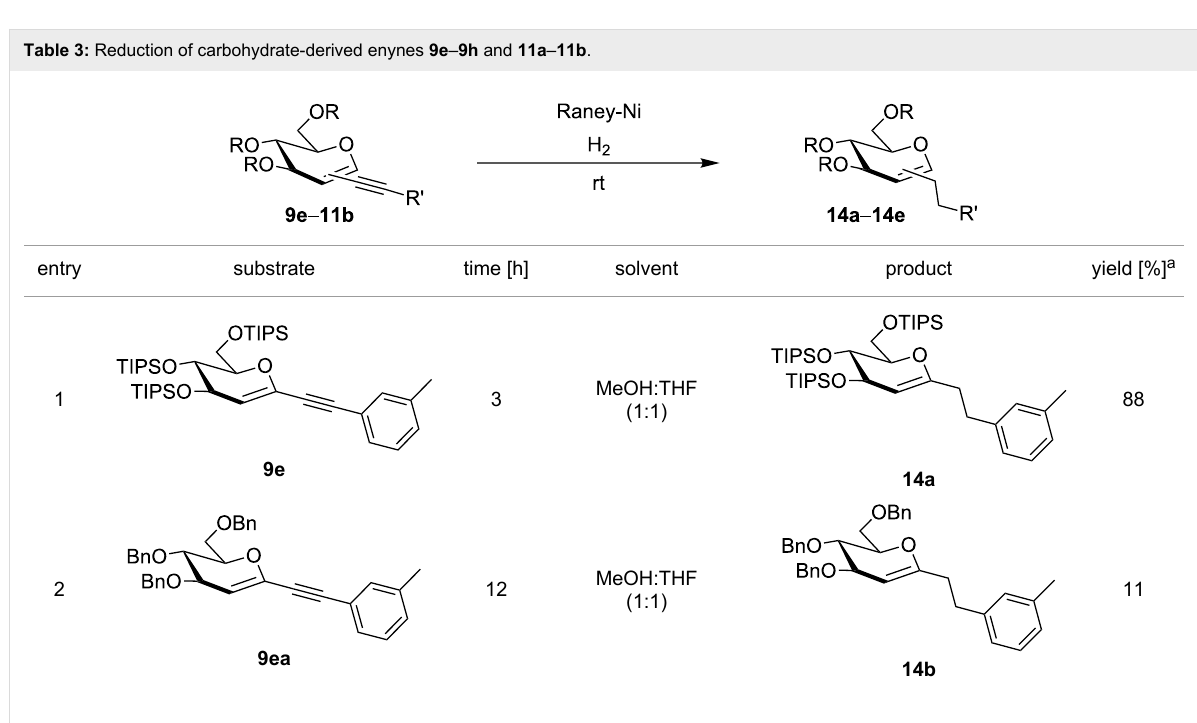
a Isolated yields.